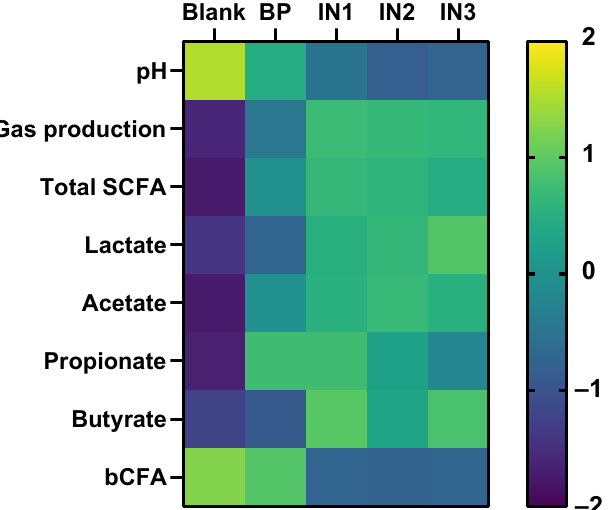
Figure 7. Effect of baobab fruit pulp powder (BP) fermentation on bacterial metabolic parameters during 48 h fecal batch incubations of three healthy adults compared to a ‘no substrate control’ control and three different types of inulin (IN1, IN2, IN3) as tested by Van den Abbeele et al. [25]. BP data were obtained as disclosed in this study. BP was administered at ~2.6 g fiber/L, while inulin was tested at 5 g/L. Average differences between treated and ‘no substrate control’ incubations for three donors were calculated for each parameter. Subsequently, all values were standardized within each parameter to enable comparisons across parameters on a single scale.